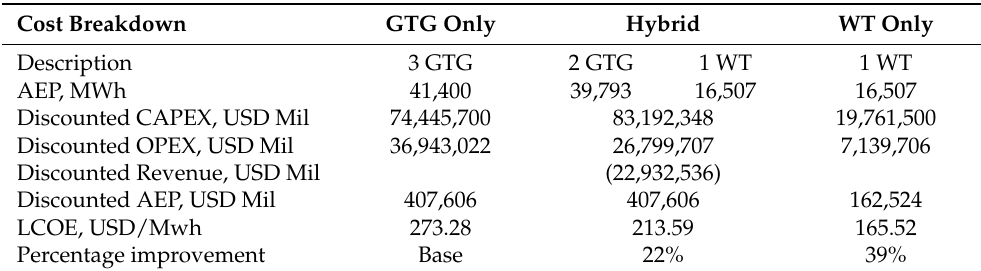
Table 5. LCOE cost